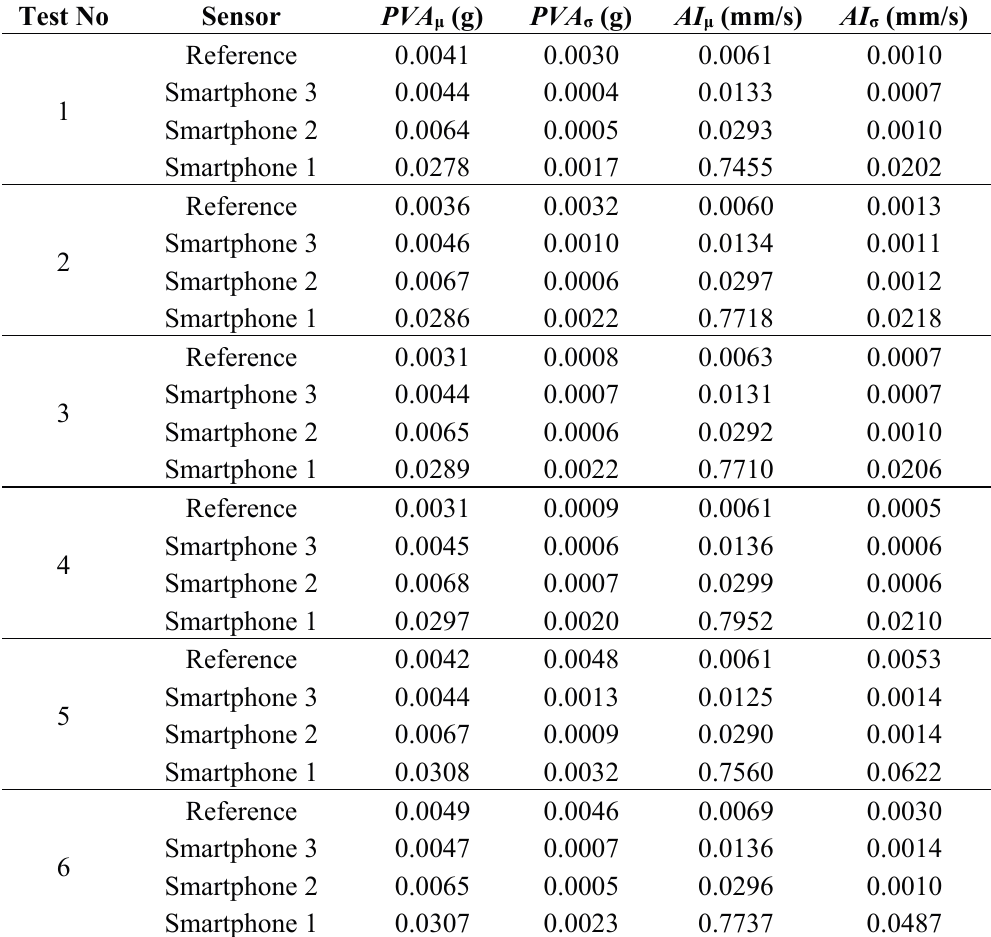
Table 4. Peak vertical acceleration (PVA), Arias intensity mean and standard deviation